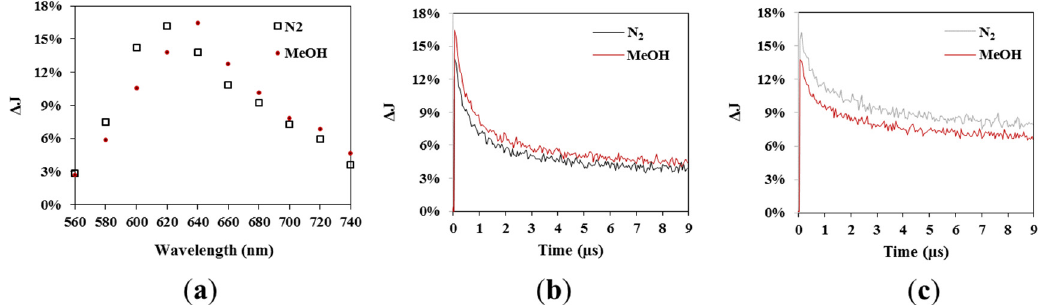
Figure 7 . Transient absorption spectra in N 2 and in methanol atmosphere at 0.1 µs after the excitation ( a ). Transient absorption signal measured in N 2 and MeOH atmosphere at 640 nm ( b ) and at 620 nm ( c ).